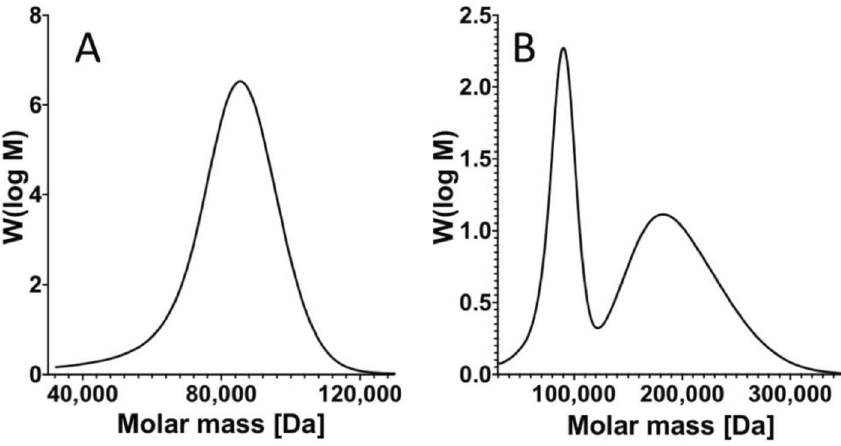
Figure 1. Exemplary GPC experiment results of bimodal and uniform MWD polystyrene; ( A ) narrow uniform MWD, Mw = 91 kDa, PDI 1.04; ( B ) bimodal MWD, blend of Mw = 91 kDa, PDI = 1.04 and Mw = 200 kDa, PDI =